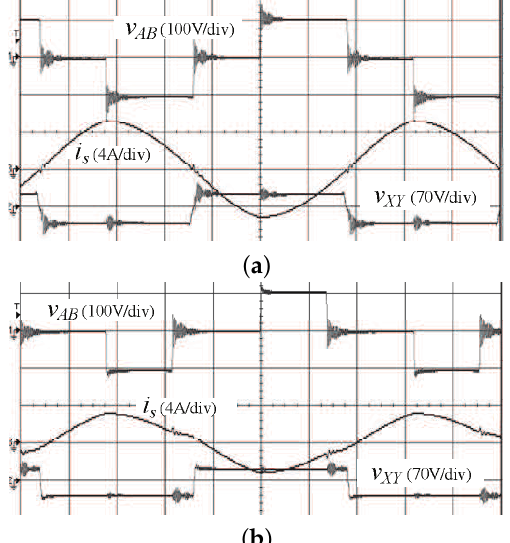
Figure 14. Experimental plots at V L = 28.8 V, output power: ( a ) P o = − 200 W; ( b ) P o = − 100 W. Time scale: 1.52 µ